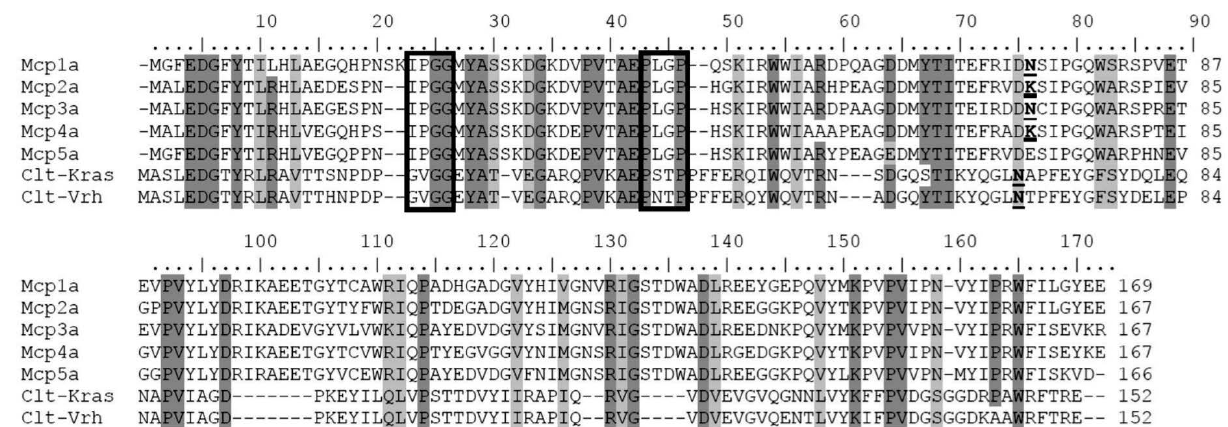
Figure 1. Alignment of mycocypin deduced amino acid sequences. Identical residues are highlighted in dark grey and similar residues in light grey. Amino acid sequences of macrocypins (Mcp) and clitocypins (Clt) were aligned with the BLOSUM62 matrix. Residues forming inhibitory loops that inhibit papain-like proteases are boxed. P1 residues, crucial for the inhibition of legumain or trypsin, are underlined and shown in bold. (Mcp – macrocypin, Clt-Kras and Clt-Vrh are native sequences of clitocypin isolated from fruiting bodies collected in the two widely separated regions, Kras and Vrh in Slovenia.)